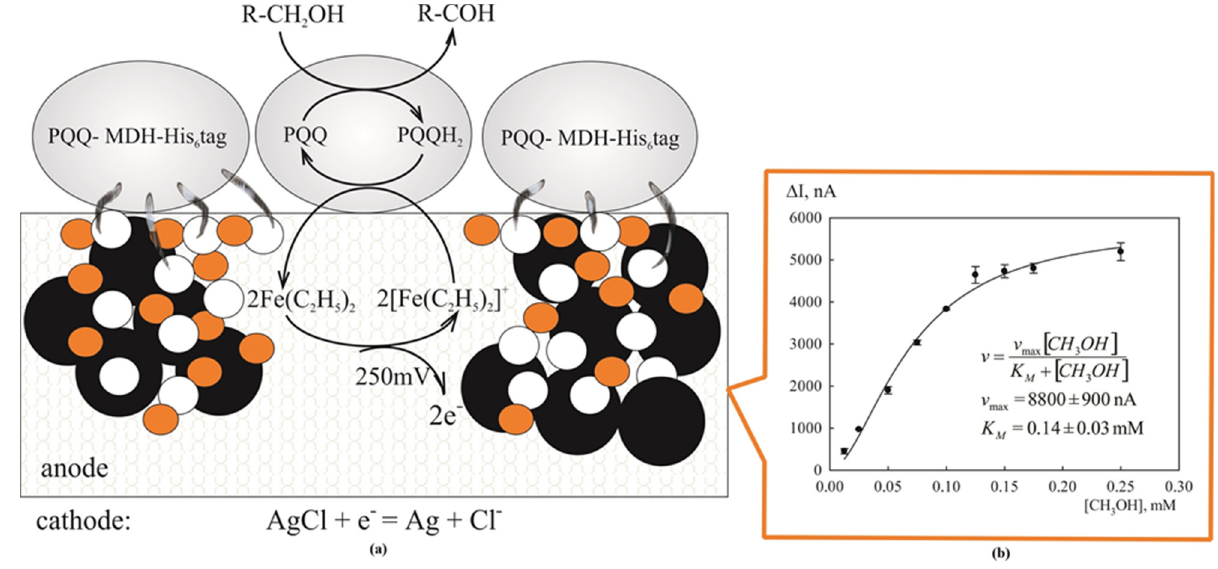
Figure 4. Process occurring upon oxidation of primary alcohols under the action of PQQ-cofactor- containing MDH-His 6 -tag in presence of ferrocene ( a ). Dependence of amperometric MDH-His 6 -tag -based mediator biosensor response ( ∆ I) on methanol concentration ( b ). Biosensor operation condi- tions: 50 mM potassium phosphate, pH 8.0, supplied with 15 mM NH 4 Cl;.